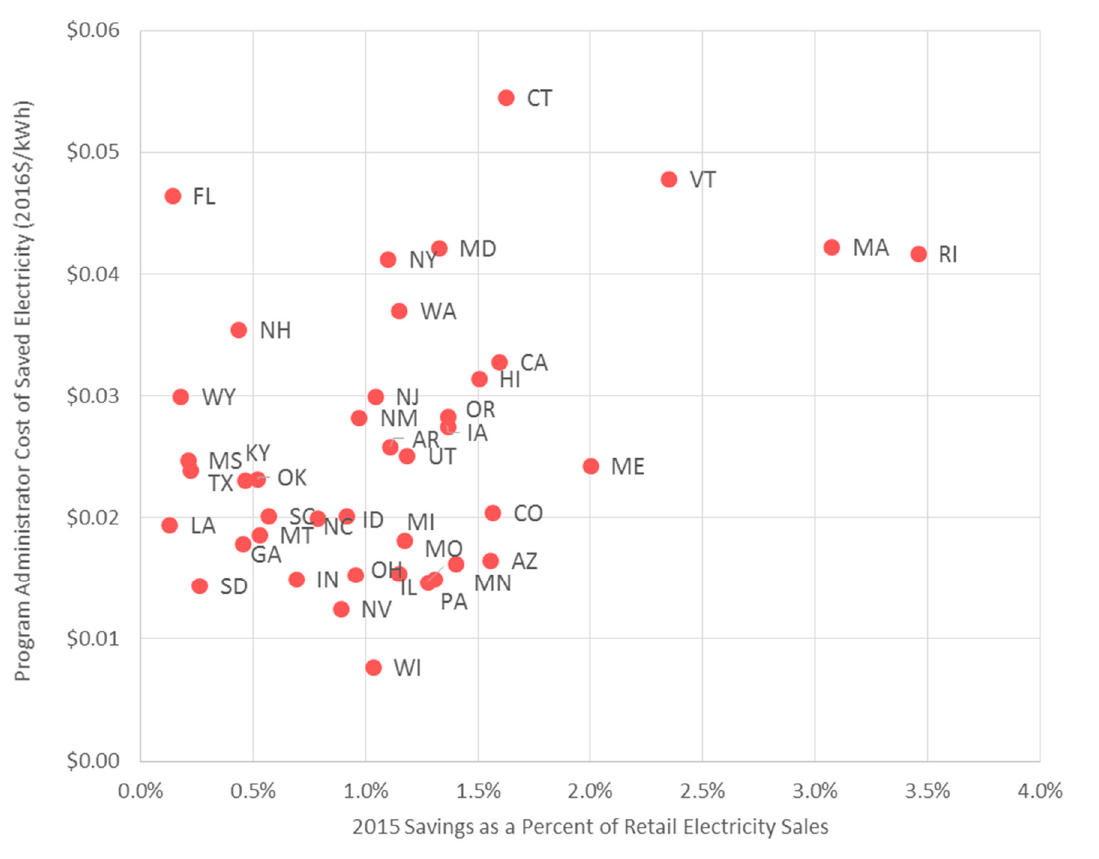
Figure 6. The 2015 program administrator CSE compared to program savings as a percent of 2015 retail electricity sales: savings-weighted averages by state. Note: PA CSE values for states in this figure only include the 2015 program data and thus do not necessarily match state the values in Figure 5, which included the entire 2009–2015 period.